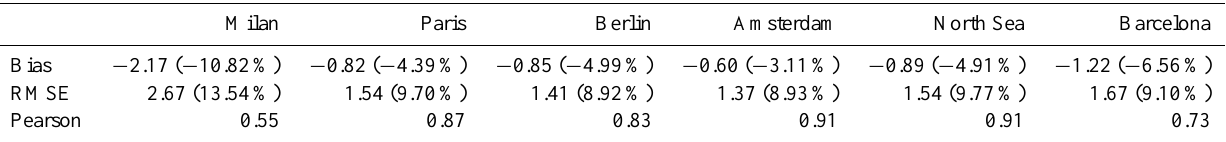
Table 7. Same as Fig. 6 but for the surface–3km TOCs.